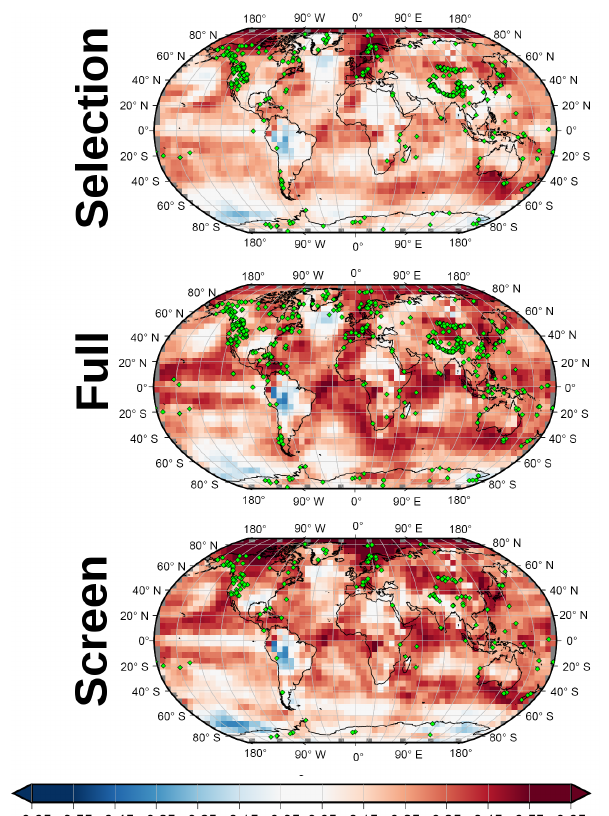
Figure 9. Correlation maps similar to Fig. 8 for the RMSE-AM variant of the AM method. The three maps depict the result obtained using each of the three variants of the PAGES 2k network described in Sect. 2.2. In all cases the green symbols indicate the location of the proxies employed in the